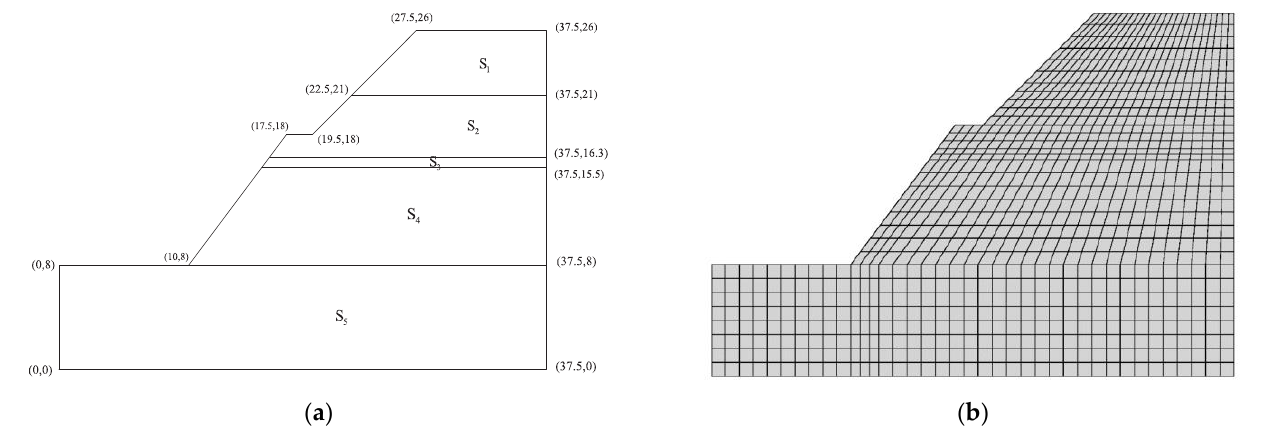
Figure 10. Geometry and adopted mesh. ( a ) geometry; ( b ) adopted mesh.